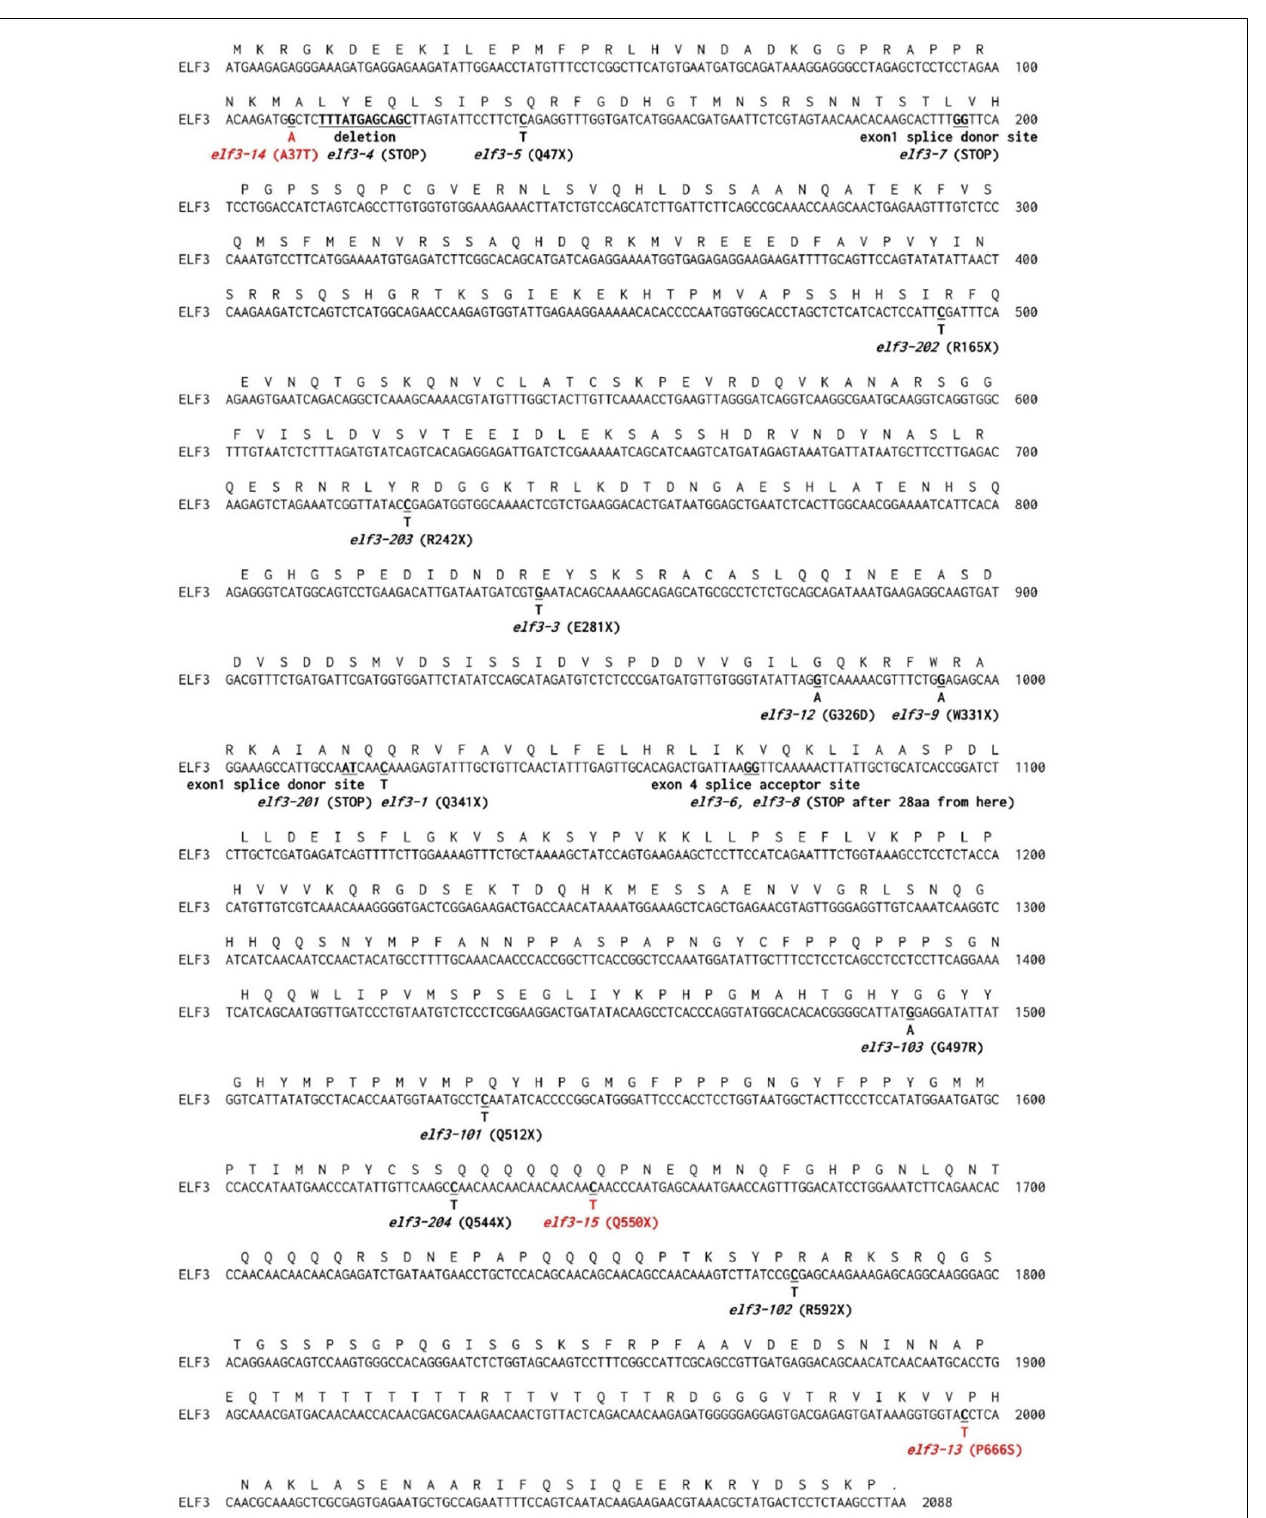
Frontiers in Plant Science |